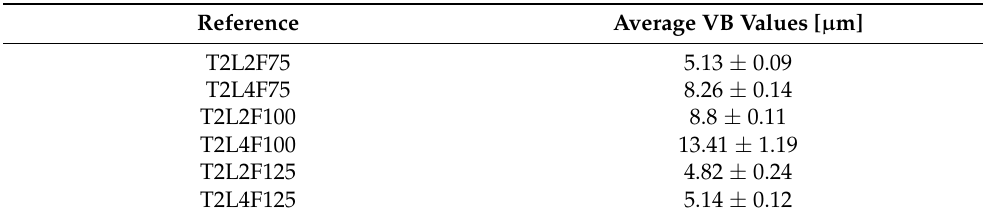
Table 8. Average VB values, obtained from measurements performed in the clearance faces of T2 tools.